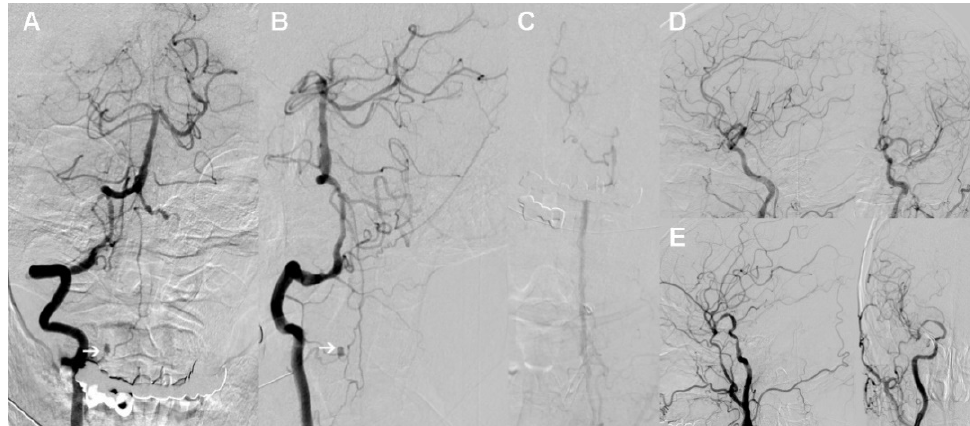
Figure 2. Digital subtraction angiography of the patient. ( A , B ) Anteroposterior ( A ) and oblique ( B ) views of the right vertebral artery show an isolated aneurysm in the medial V2 segment branch. ( C – E ) No obvious aneurysm or other vascular malformations in the left vertebral artery ( C ) and bilateral internal carotid arteries ( D , E ) observed.